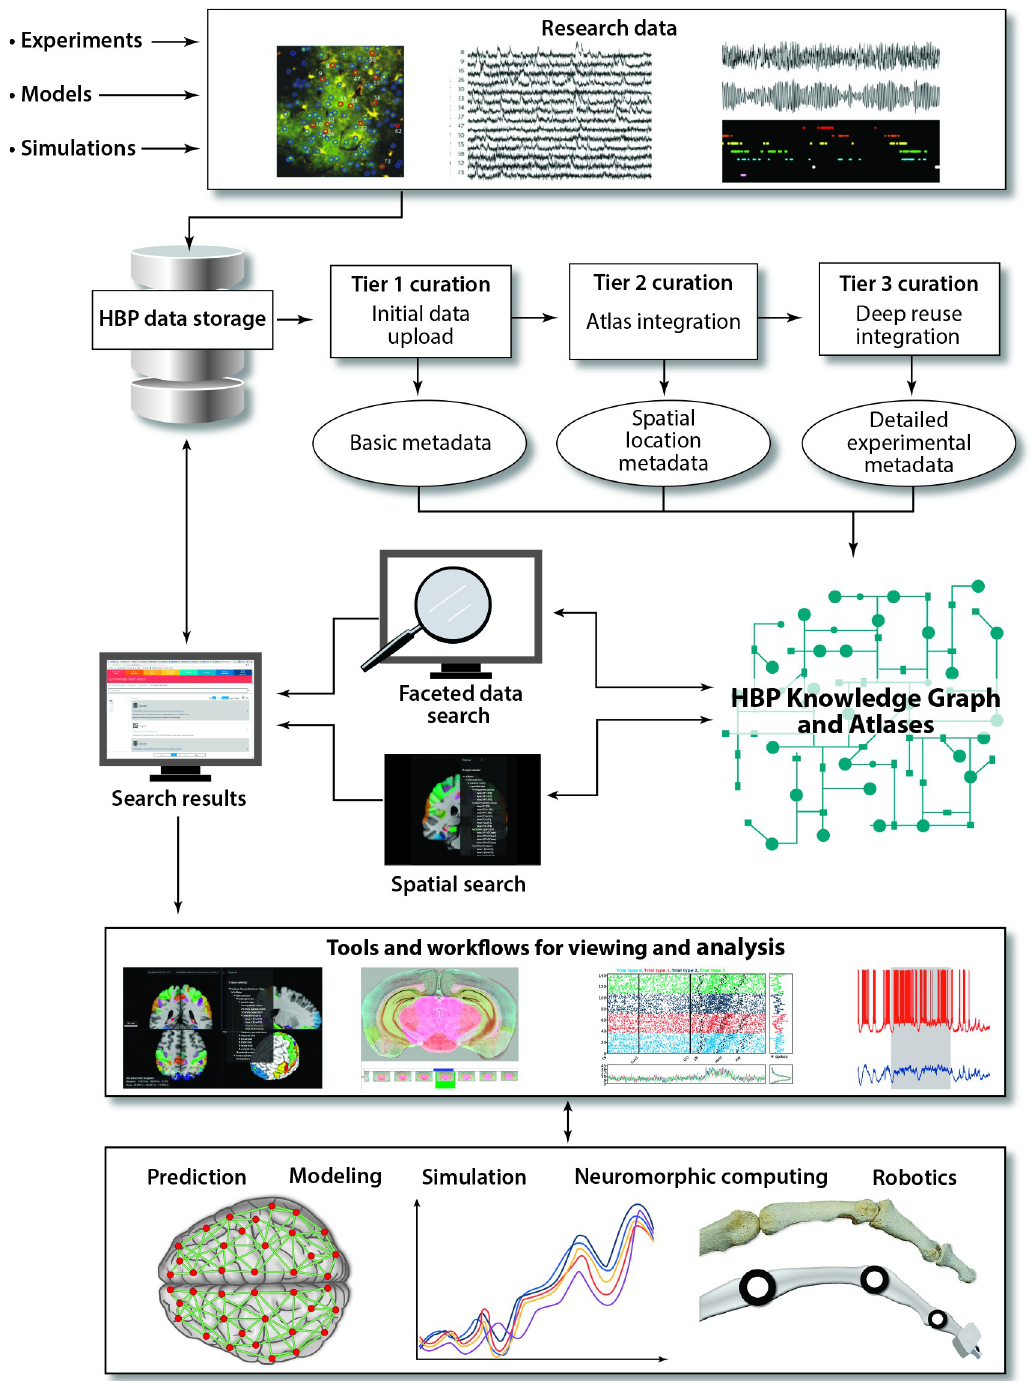
Fig 2. The HBP integrated platform. Research data from experiments, models, or simulations are uploaded to data storage at the HBP high-performance computing centers. The data are tagged with metadata through a 3-tier curation process covering basic metadata, metadata connecting the data to the HBP Atlases, and additional detailed metadata depending on the data modality. The data are made accessible for users through searches for metadata (“Faceted data search” or “Spatial search”) in